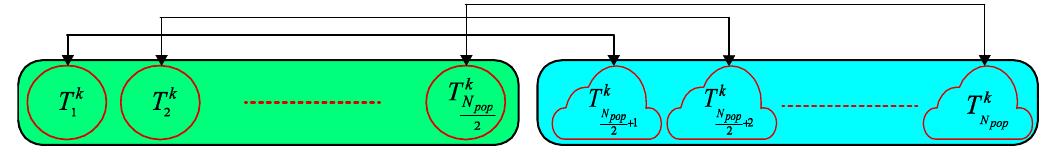
Figure 5. Pairs of environment and cooling objects.